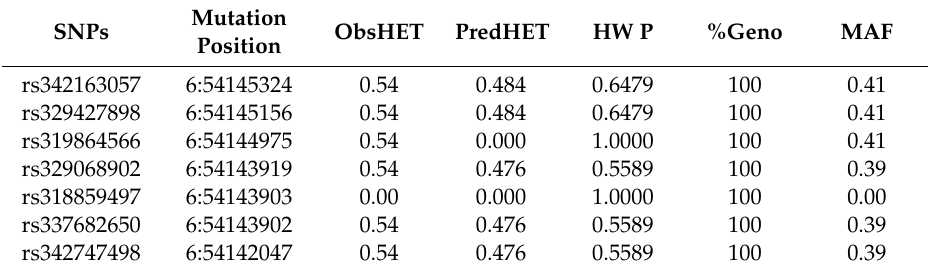
Table 2. The HW and MAF of SNPs in porcine HSD17B14 gene in Large White pigs.